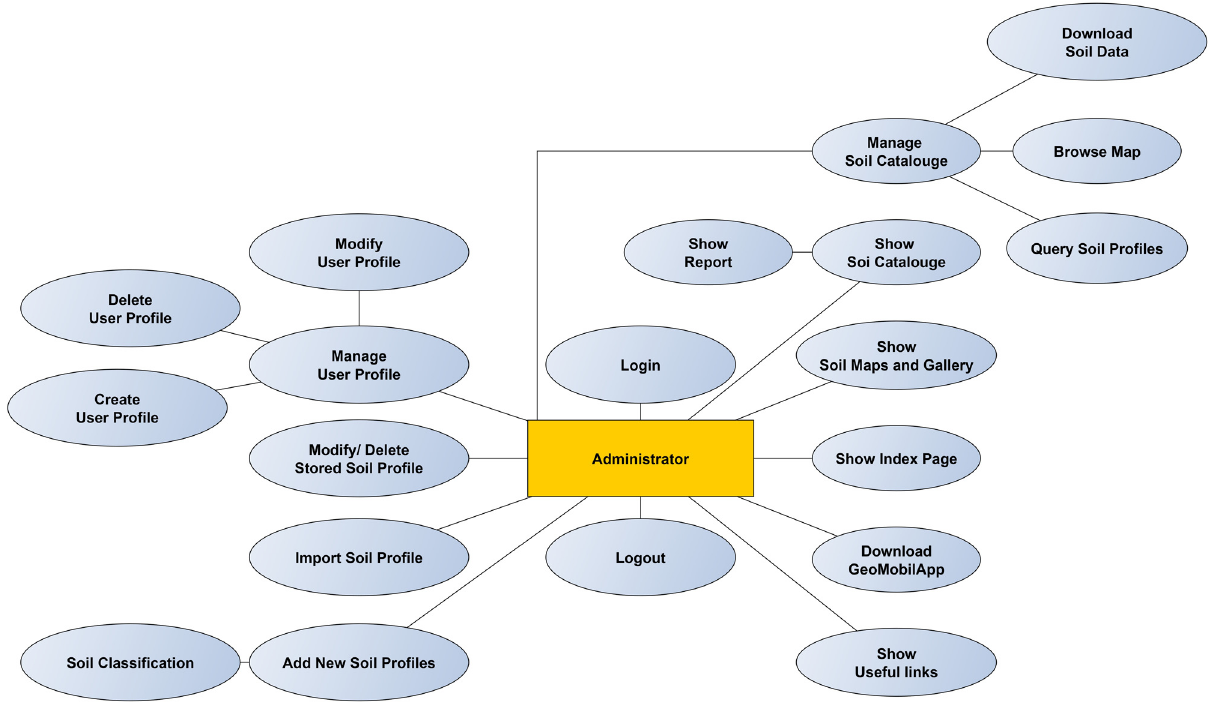
Figure 2: Use Case diagram of